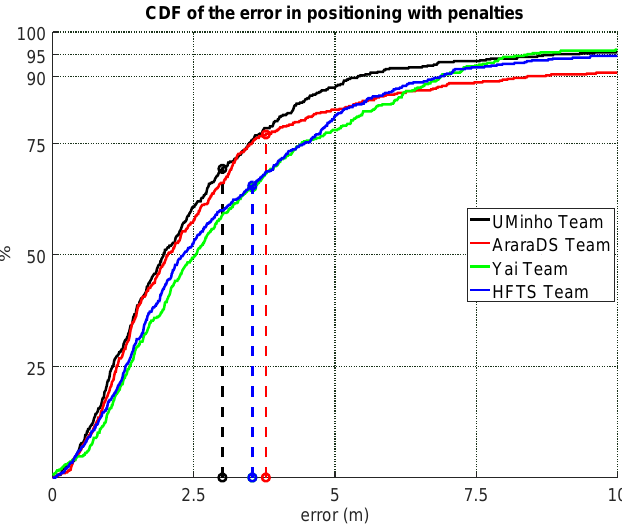
Figure 2. Competition Results in CDF (Cumulative Distribution Function) representation for the seven logfiles as a whole (CDF represented by a solid lines for each team). Alternative metric based on the mean positioning error (applying floor penalties) is represented by vertical dashed